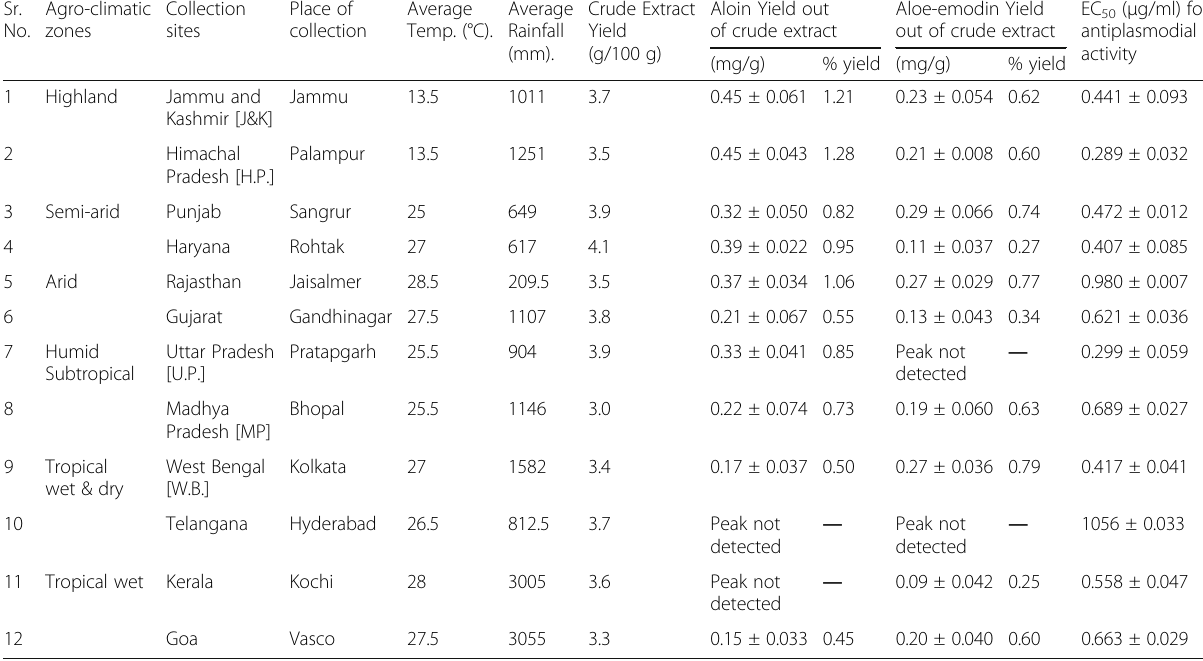
Table 1 Geographical parameters, crude extract yield, yield of aloin and aloe-emodin and antiplasmodial EC 50 values of Aloe vera aqueous extracts collected from different sites of India Sr. Agro-climatic No.